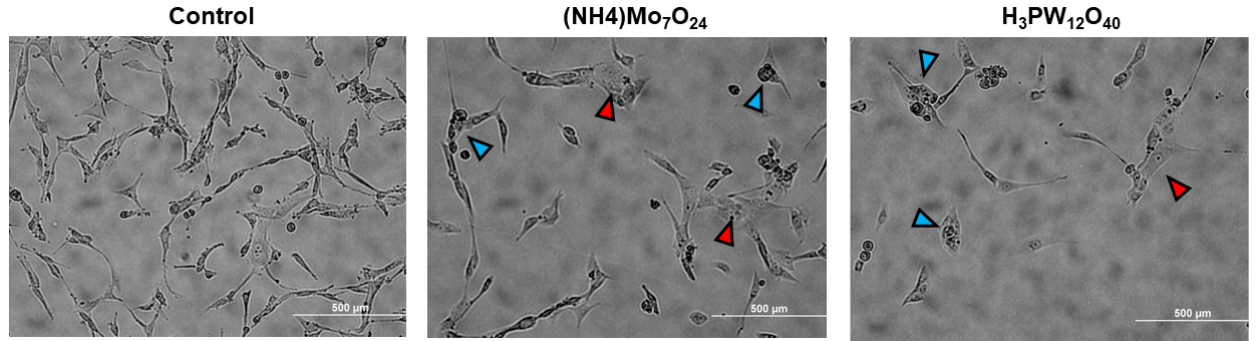
Figure 3. POM-induced morphological changes. Following 48 h treatment of U87 cells with 500 µM (NH4)Mo 7 O 24 and H 3 PW 12 O 40 light microscopic images were collected to visualize morphological changes associated with the treatment. Blue arrows indicate multi-nucleated cells or cells with cellular fragmentation and red arrows indicate cellular swelling.